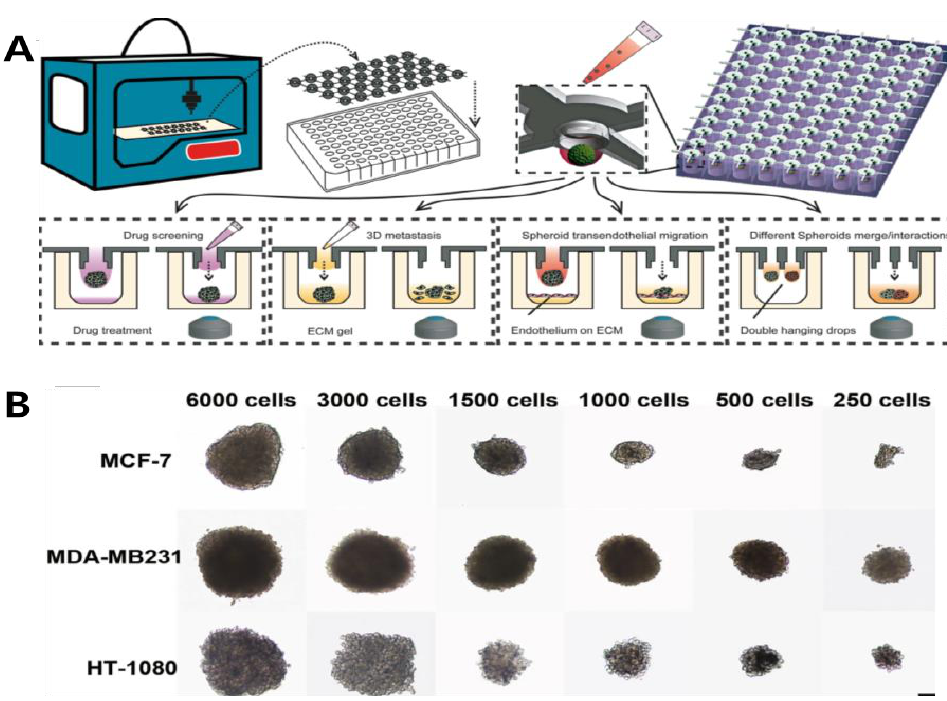
Figure 2. ( A ) Designing 3D-printed hanging-drop derivatives to investigate multicellular tumor spheroids. The device was printed for cancer spheroid formation on a 96/384 culture plate. Different types of assays are performed: drug screening, 3D metastasis, spheroid transendothelial migration, and spheroids merge/interactions. ( B ) Characterization of different cell lines cultured over two days with varying ratios. Reprinted with permission from [28]. Copyright 2019, Springer Nature.